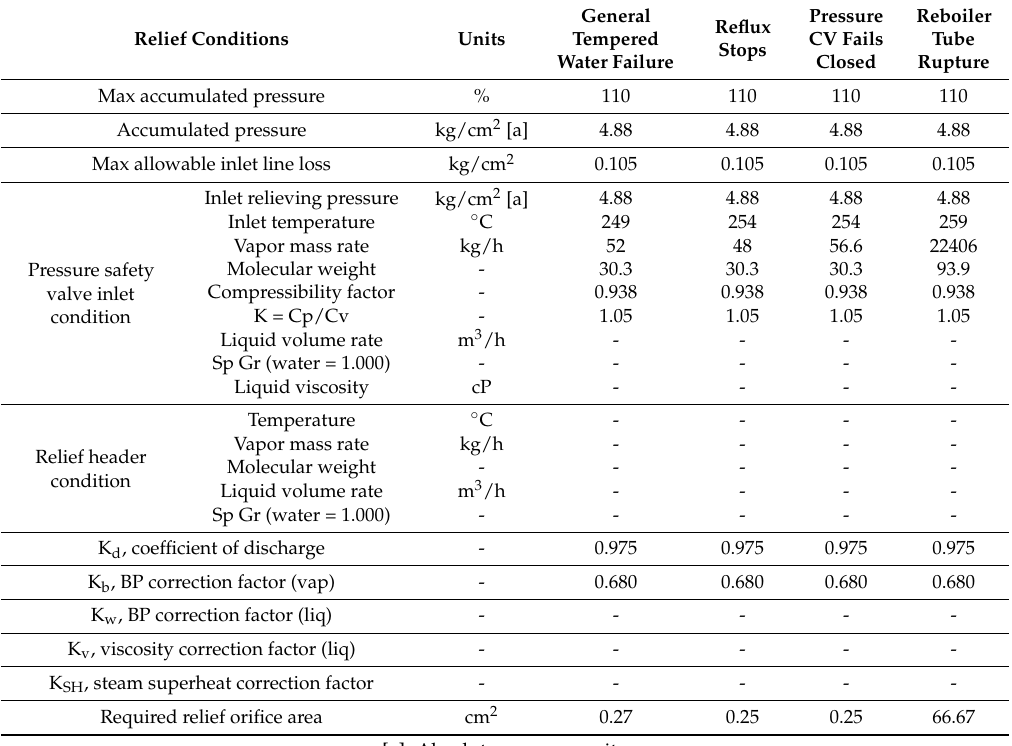
Table 6. PSV relieving cases of crude phenol column.